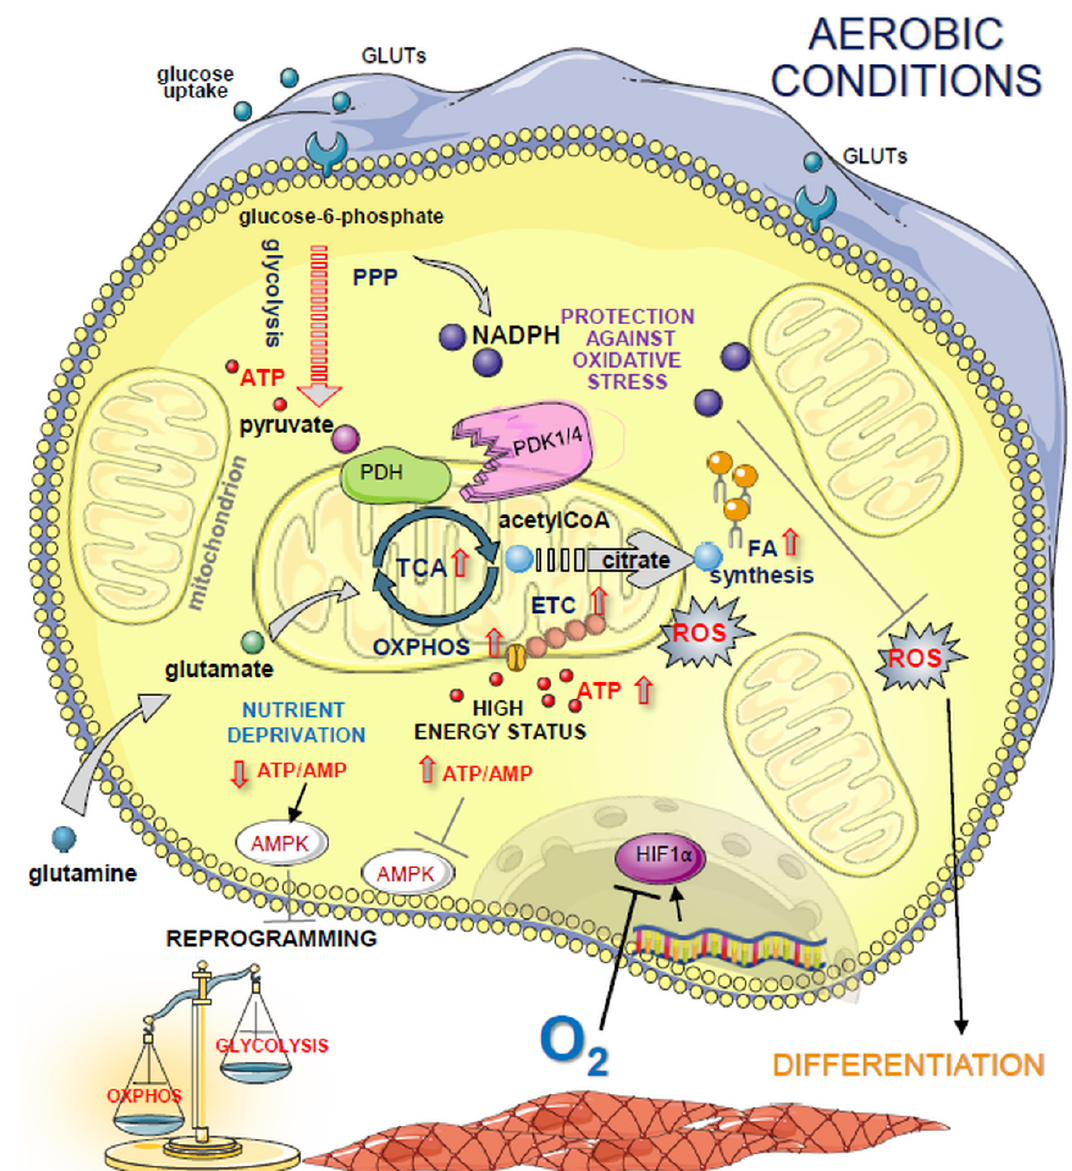
Figure 4. Outline of the cellular oxidative metabolism under normoxia. In O 2 abundance, glucose catabolism to pyruvate is active. Next, pyruvate is transported to mitochondria to fuel the TCA cycle. The rate-limiting enzyme, PDH complex, is dephosphorylated and active. Glucose carbons form acetyl-CoA, and, as citrate, are transported to the cytoplasm for FA biosynthesis. ATP is produced mainly via OxPhos, with the generation of ROS. The continuous degradation of the HIF1 α protein occurs under high oxygen levels. OxPhos favors spontaneous differentiation of PSCs. Abbreviations: AMP—aden- osine monohosphate; AMPK—adenosine 5’-monophosphate-activated protein kinase; ATP—adenosine triphosphate; ETC—electron transport chain; FA—fatty acids; GLUTs—glucose transporters; HIF1 α —hypoxia inducible factor 1 α ; NADPH—nicotinamide adenine dinucleotide phosphate; OXPHOS—oxidative phosphorylation; PDH—pyruvate dehy- drogenase; PDK1/4—pyruvate dehydrogenase kinase 1/4; PPP—pentose phosphate pathway; ROS—reactive oxygen spe- cies; TCA—tricarboxylic acid.